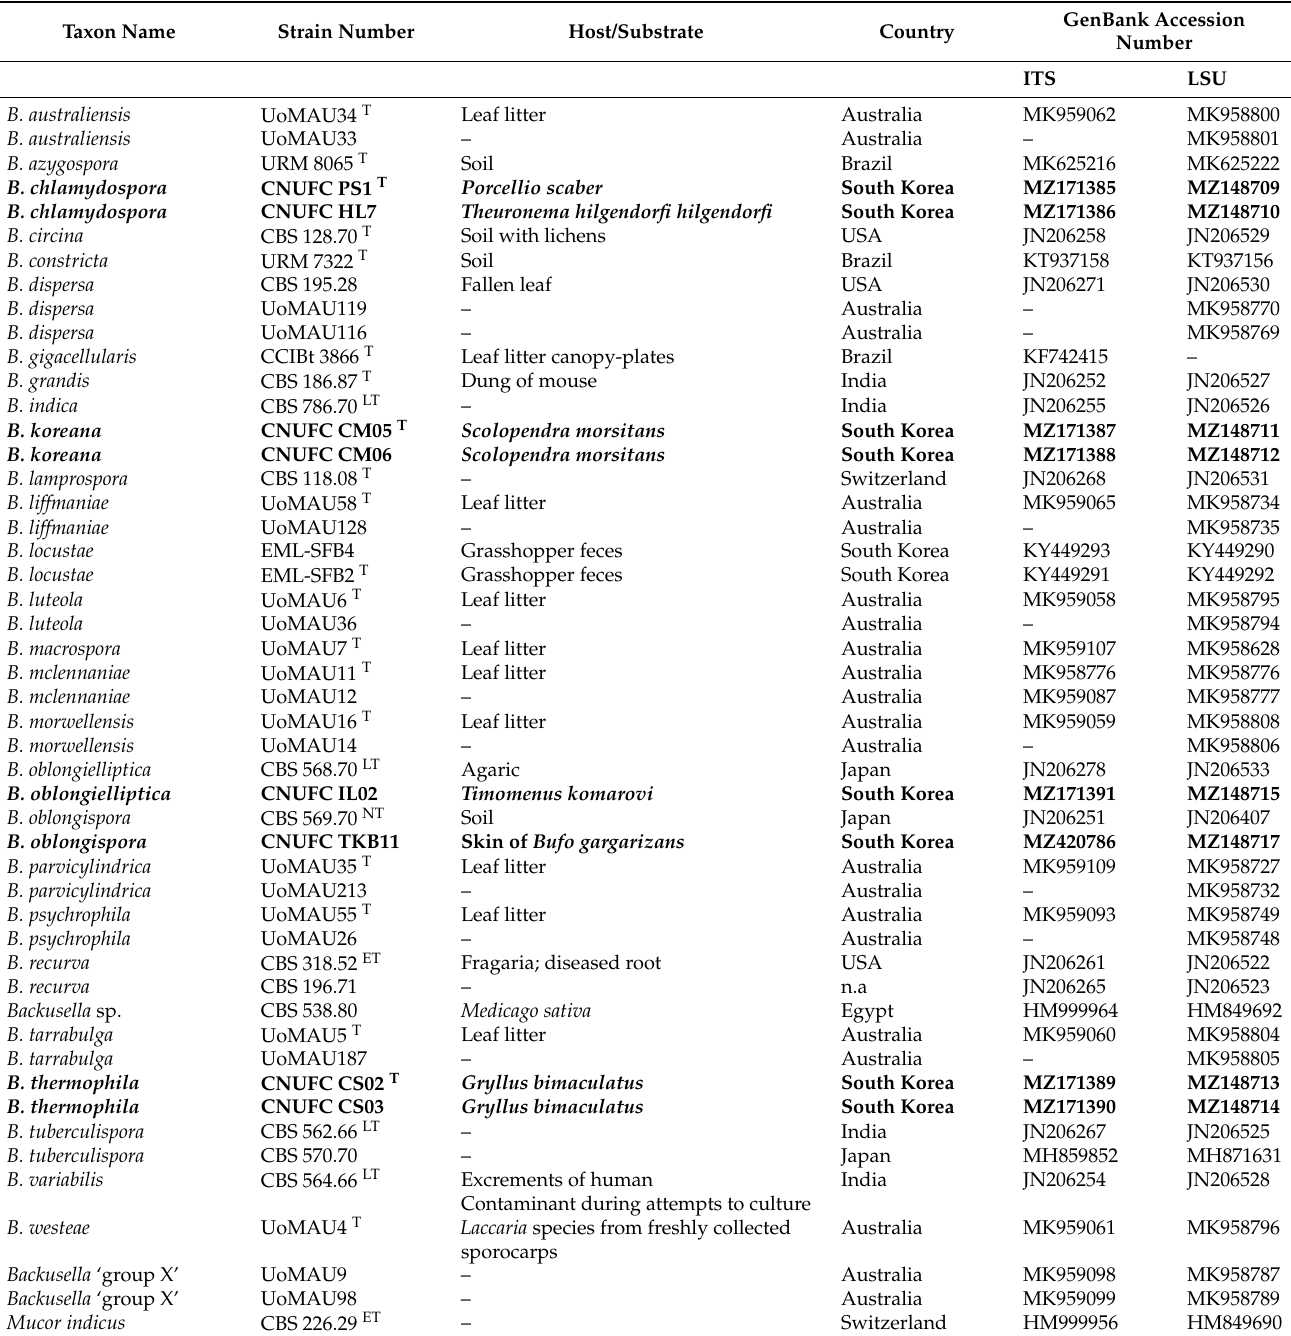
Table 1. Taxon, collection number, sequence, and GenBank accession number relative to all ITS and LSU sequences used in this